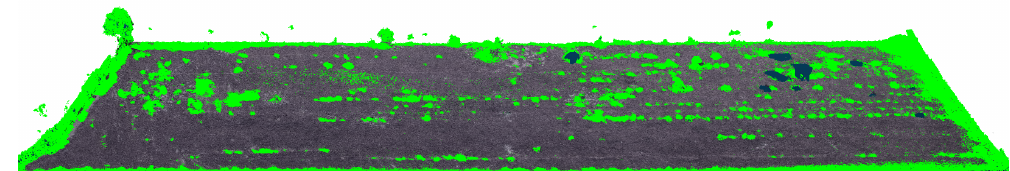
Figure 14. Classified vegetation marked in green.